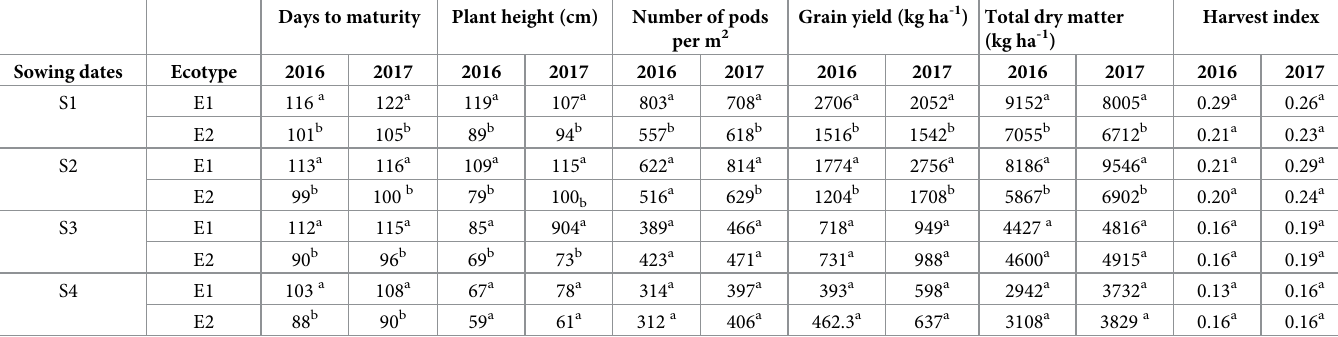
conditions and better plant establishment, lower density leads to less competition between plants and provides better conditions for utilization of humidity, nutrients, space and light which resulted in better growth of the plants and produces more flowers and pods per plant. However, increase in the number of pods per m 2 was observed at high plant density in delayed planted guar crop. This trend might be attributed to late in the sowing because shortened growth period decreased vegetative and reproductive growth (plant height, number of pods per m 2 , number of grain per pod and grain weight) in the plant, but more plant populations with increasing number of plants per unit area can be compensated with the low number of pods per plant. Also, the results showed that guar ecotypes in an early sowing treatment pro- duced more pods per area (Tables 6 and 7). This trend might be attributed to the late sowing Table 7. Some agronomic traits affected by sowing date × ecotype interaction effect.